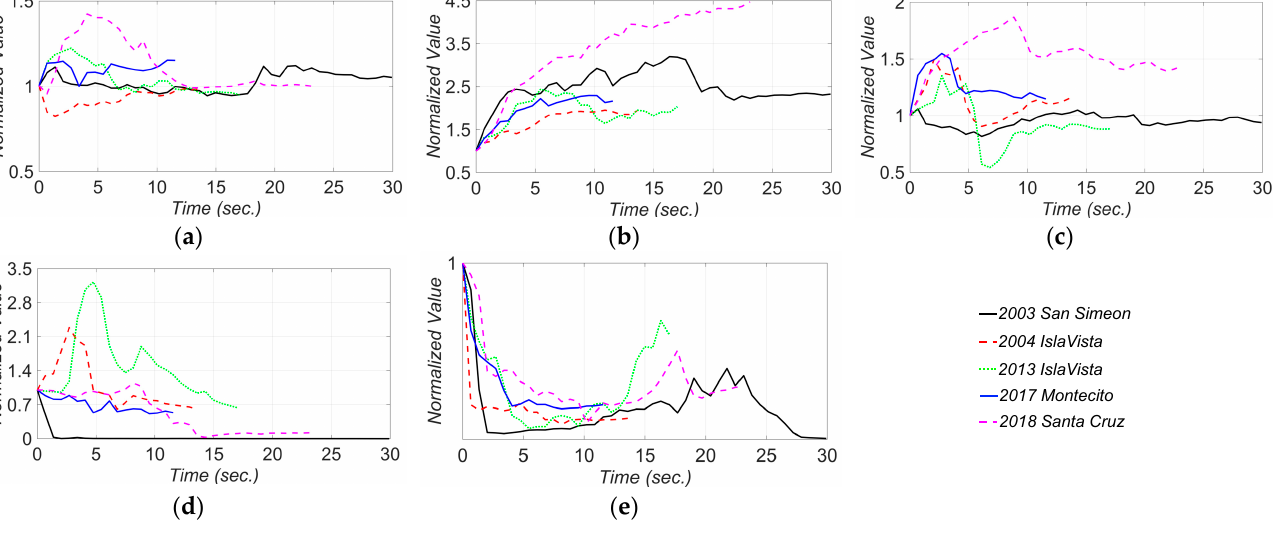
, ( c ) k b , ( d ) a 0 , and ( e ) a 1 for different earthquakes. L T